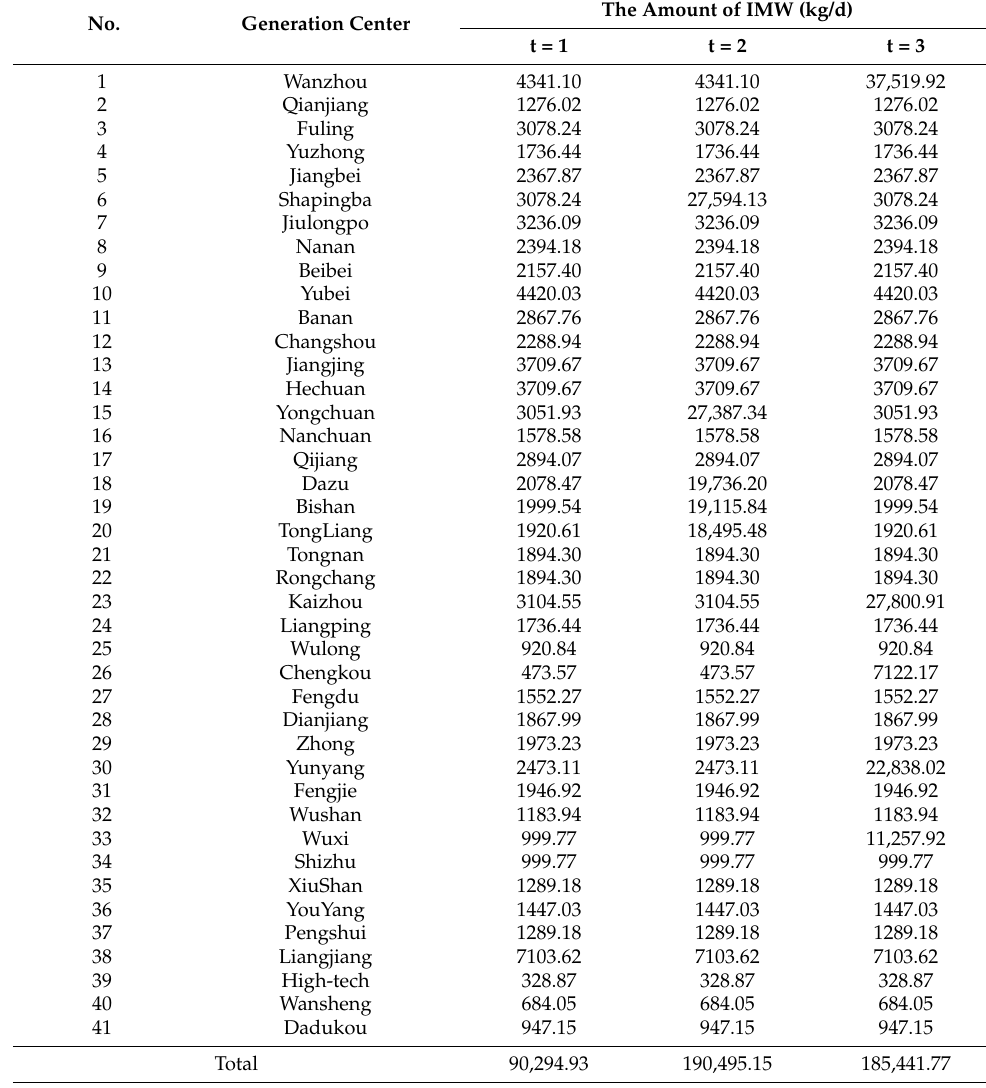
Table 4. The amount of IMW from every district in different outbreak situations.